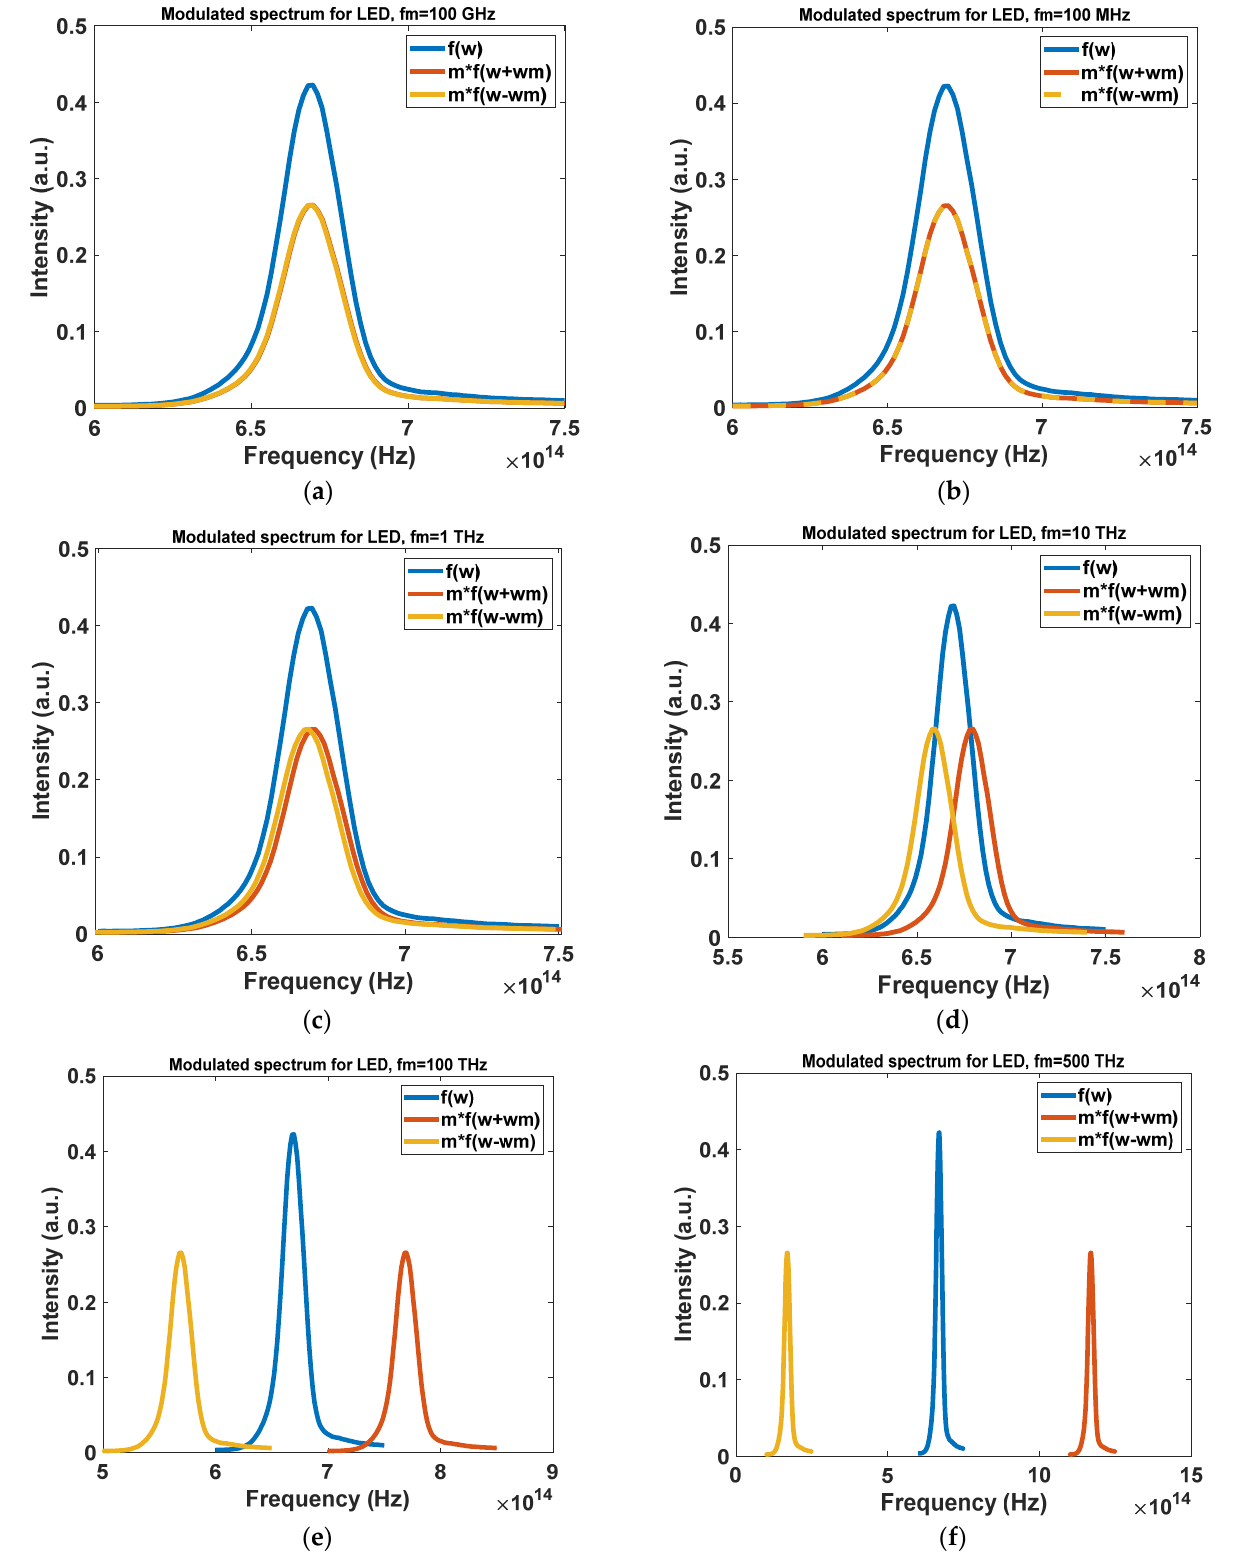
Figure 9. The spectrum of the modulated input light by LED. ( a ) Modulated LED light for 100 GHz. ( b ) Modulated LED light for 100 MHz. ( c ) Modulated LED light for 1 THz. ( d ) Modulated LED light for 10 THz. ( e ) Modulated LED light for 100 THz. ( f ) Modulated LED light for 500 THz.